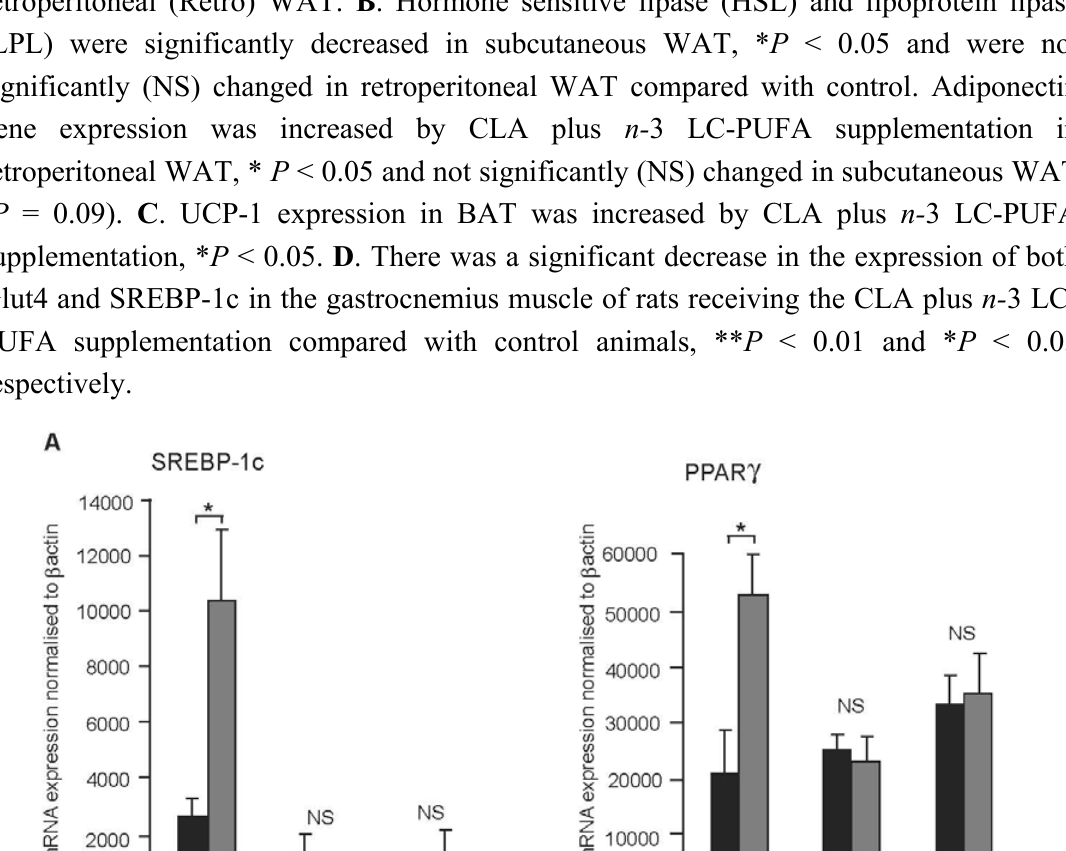
Figure 5. Effect of CLA plus n- 3 LC-PUFA supplementation on WAT, BAT and